Question: What direction does the quantity move in — increasing or decreasing?
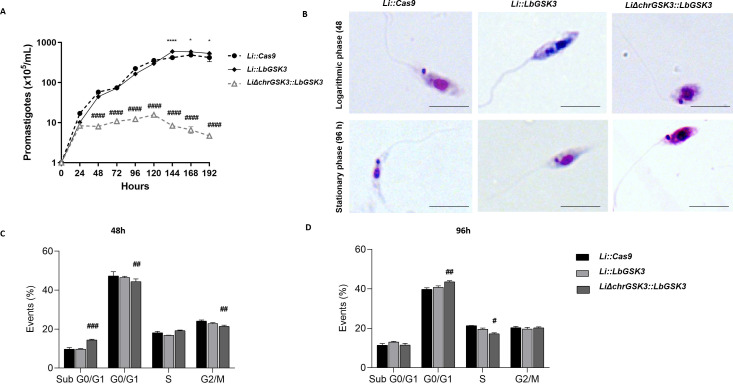
Answer: increasing